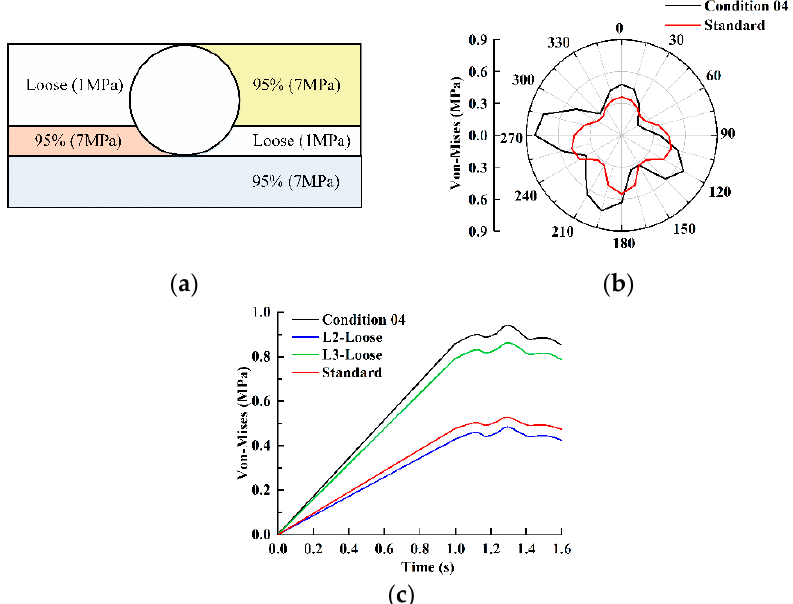
Figure 22. ( a ) The backfilling schematic of Condition 03; ( b ) the stress distribution of the pipe; ( c ) the time history curve of the left springline under Condition 03.